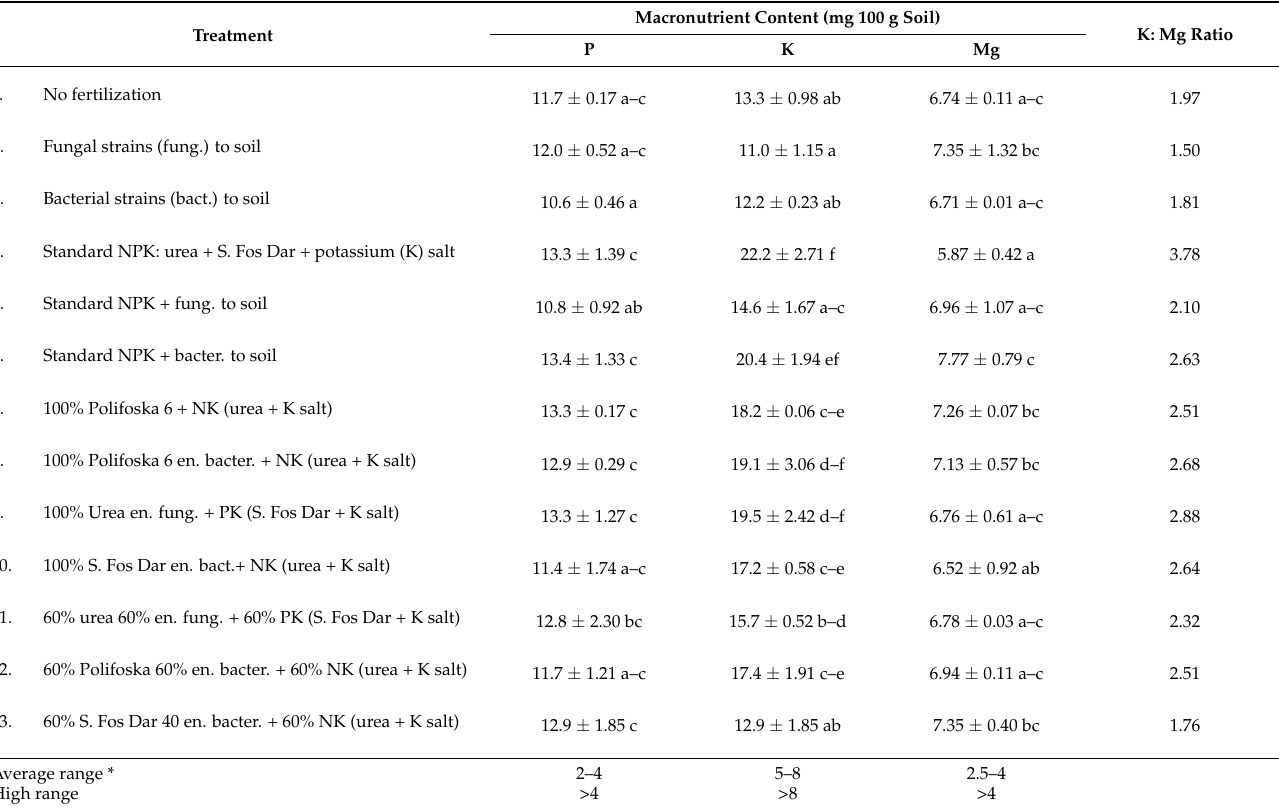
Table 12. Macronutrient content in apple orchard soil,